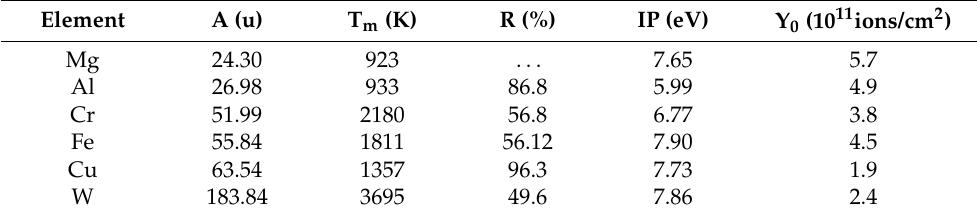
Figure 2. Copper ion emission yield ( a ) and specific ion yield ( b ) as a function of the fs-laser fluence. The two vertical lines mark the transition between different regimes. The inset in panel (a) shows the Langmuir probe (LP) data on a log-log plot. The left axis represents the LP and Faraday Cup (FC) measurements and the right axis represents the spectrally resolved intensified charged coupled device (ICCD) imaging. Reprinted with permission from [79]. Table 1. Physical properties of the selected metals: A, atomic weight; T m , melting point; R, reflectivity at 800 nm, normal incidence; IP, ionisation potential. Y 0 is the peak value of the ion yield registered along the direction normal to the target surface